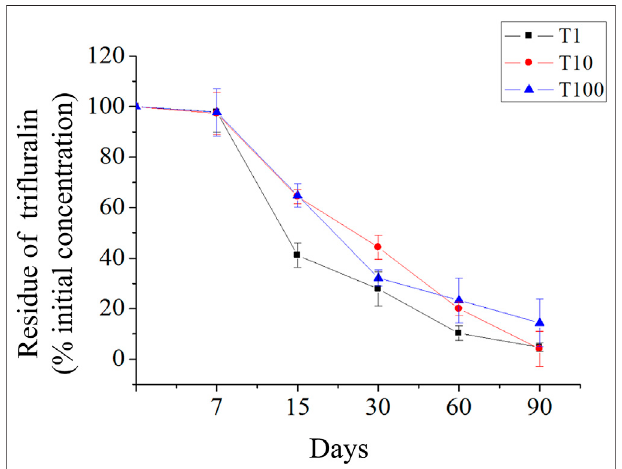
FIGURE 1 | Dynamics of tri fl uralin degradation in soil. The concentration oftri fl uralinisexpressed asthe%oftheinitialconcentrationforsampling date.